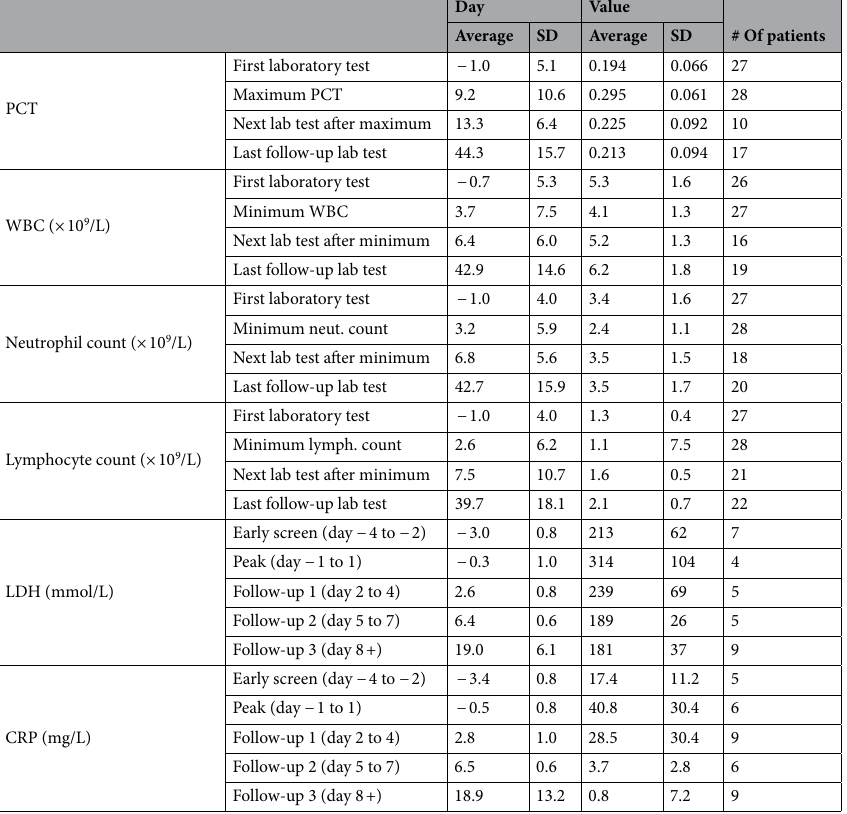
Table 3. Data used to generate the dynamic curves for PCT, WBC, and neutrophil and lymphocyte count.